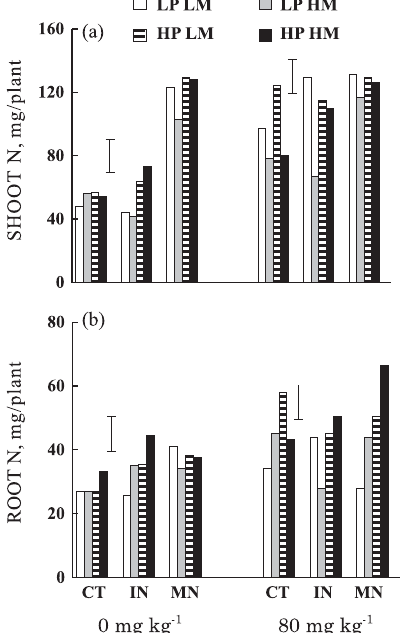
Figure 2. Accumulation of N in shoots (a) and roots (b, roots plus nodules) of common bean plants grown at two P levels applied to the soil (0 and 80 mg kg -1 ) and three N sources (CT control without N, IN inoculated with rhizobia, MN mineral N), originating from seeds with different concentrations of P and Mo (LP low P, HP high P, LM low Mo, HM high Mo); vertical bars represent the least significant difference by the Tukey test at 0.05 level, and compare seed treatments within each N source and soil P level.